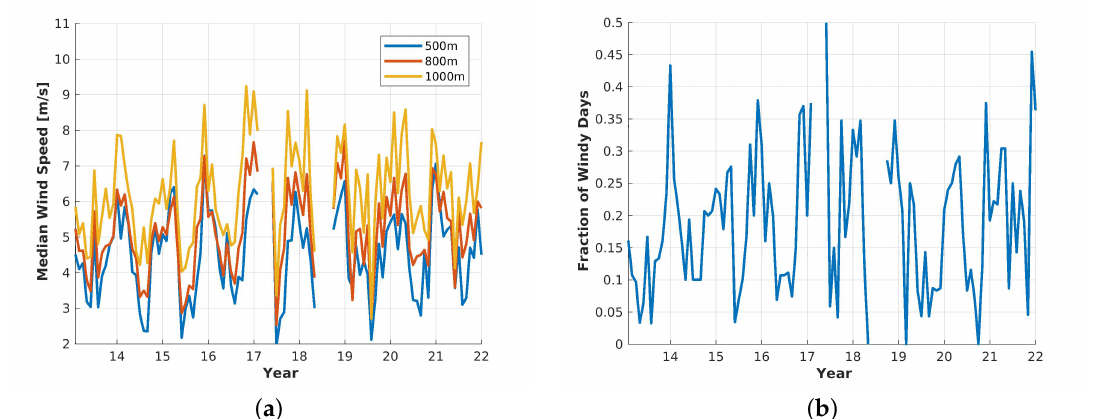
Figure 4. Monthly averaged wind speeds at three different altitudes, 500 m, 800 m and 1000 m, for the entire measurement period and the fraction of windy days ( v per month. ( a ) Monthly median wind speed, ( b ) Ratio of windy days ( v days per